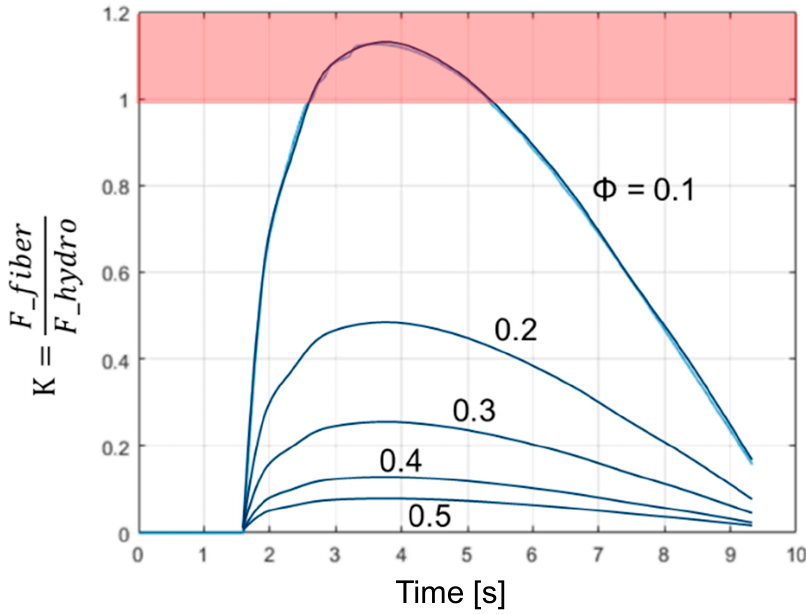
Figure 13. Development of retardation factor K in compression molding simulations with di ff erent fiber contents φ at random